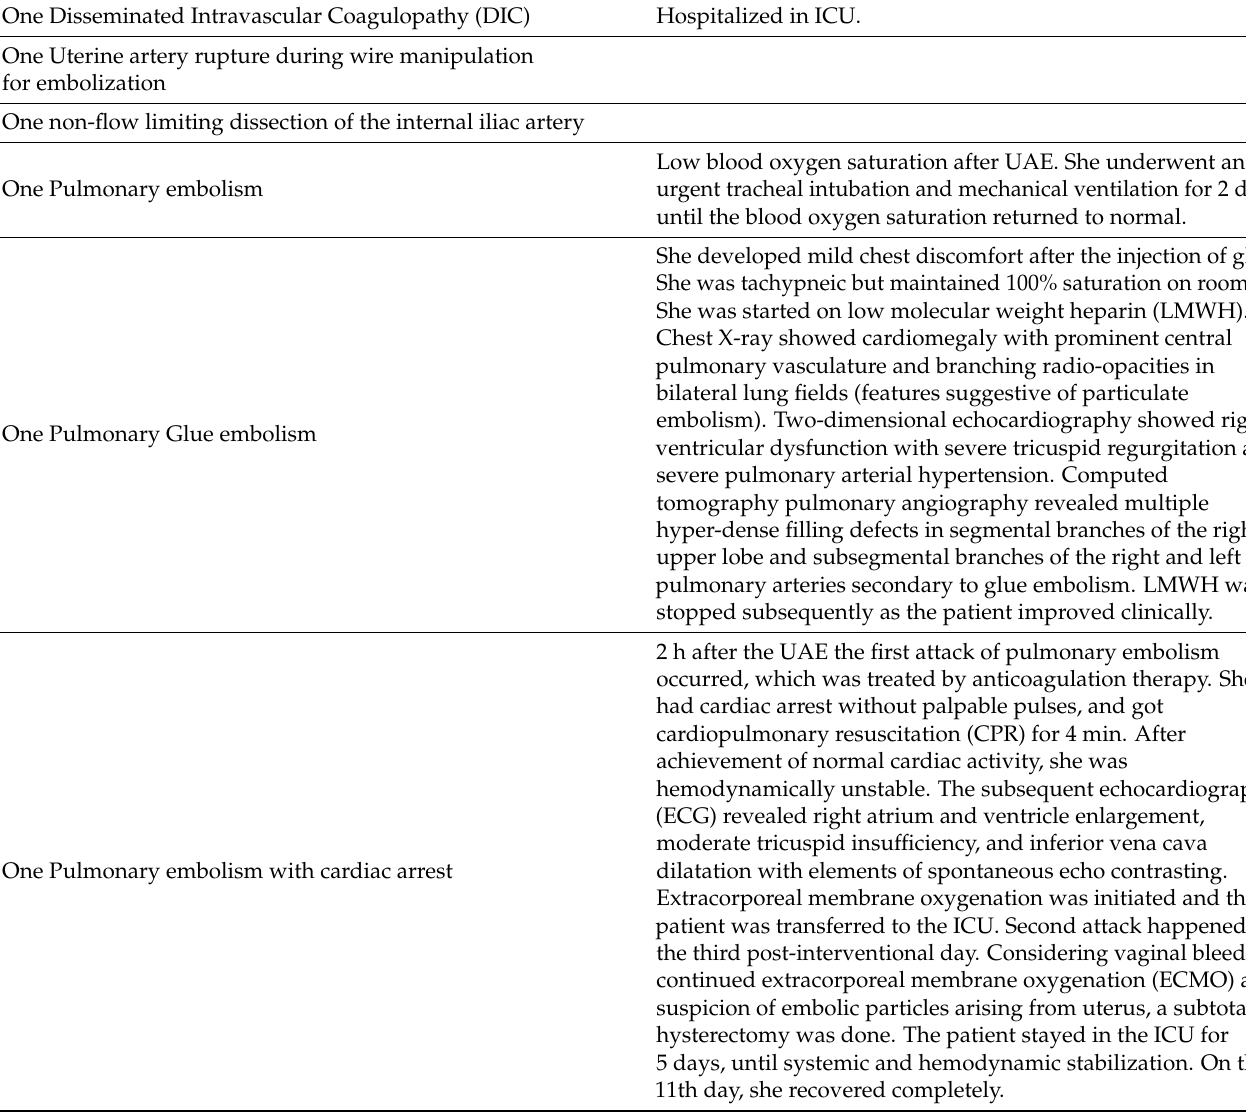
Table 6. Complications reported after embolization